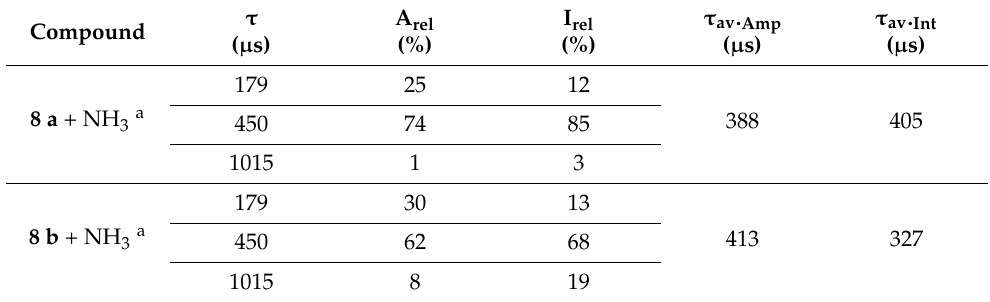
Figure 17. The luminescence decay curves of 8 a , b in air and upon exposure to NH 3 detected at 615 nm with excitation at 375 nm. Table 5. The parameters obtained by fitting of luminescence decay kinetics obtained at 615 nm with excitation at 375 nm.